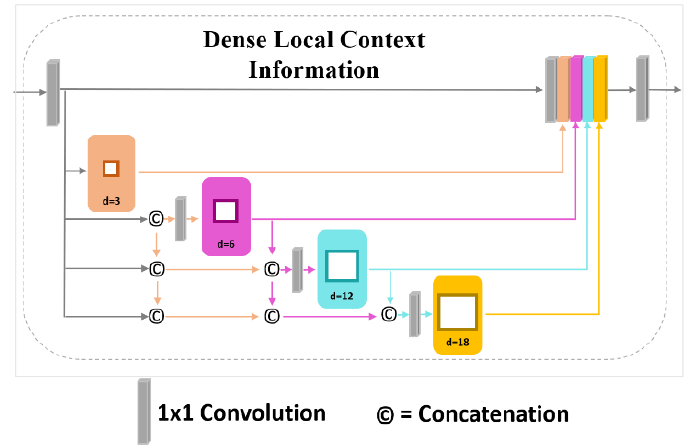
Figure 4. Detailed overview of Dense Local Context (DLC) module.